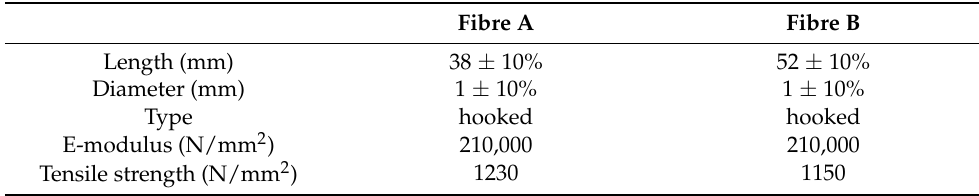
Table 2. Technical parameters of